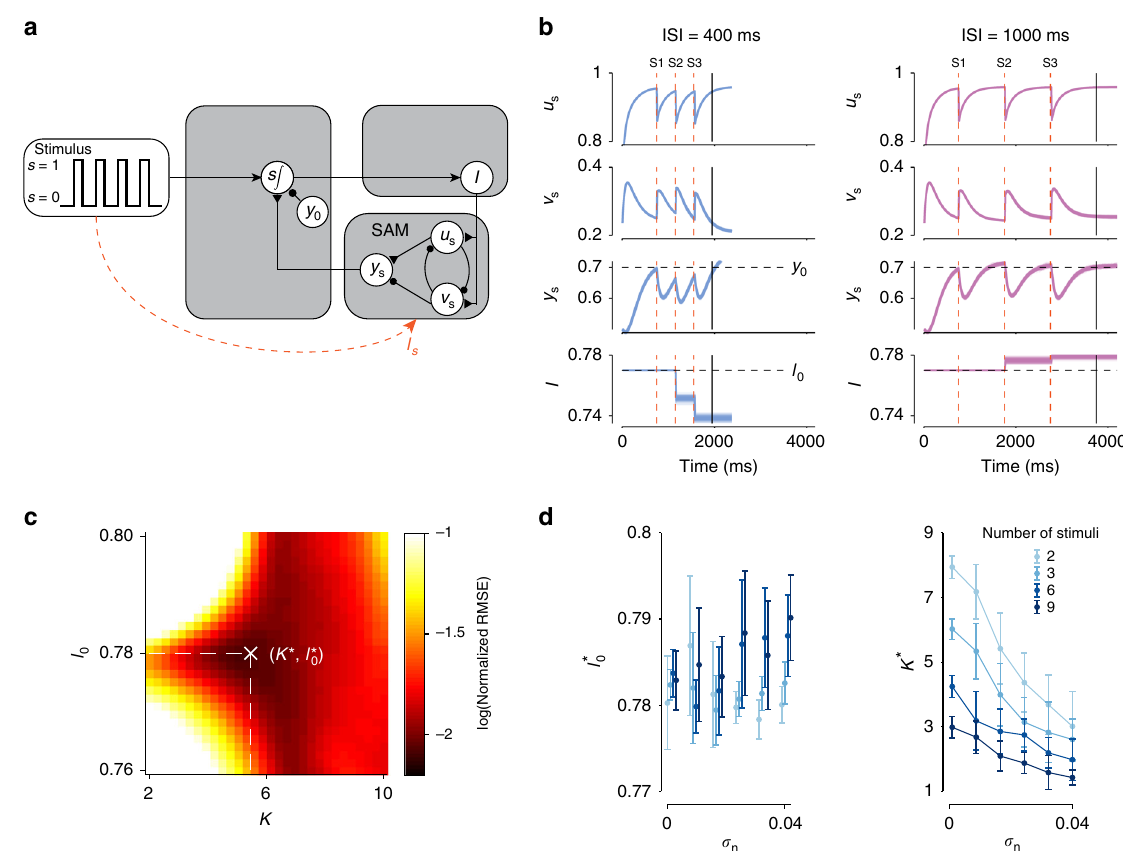
Fig. 3 Dynamic adjustment of input with the sensory anticipation module (SAM). a Architecture of the updating mechanism and SAM. The updating mechanism, represented by s ∫ , relies on the difference between the output of the SAM, y s , and the desired level of activity at the time of each stimulus. This is implemented by integrating the summed activity of y s and a tonically fi ring inhibitory unit, y 0 , into the input unit, I , when the stimulus is on ( s = 1). When the stimulus is off ( s = 0), integration is prevented and I remains constant. Dashed line indicates a stimulus input, I s , directly to u s and v s when s = 1, resetting the SAM after each stimulus. Excitatory connections are indicated by triangles, inhibitory connections are indicated by circles, and non-speci fi c synapses are indicated by arrows. b Response of the SAM units u s , v s , y s , and I to three equidistant stimuli (S1, S2, S3, vertical dashed lines) with an ISI of 400 ms (blue) and 1000 ms (pink) with K = 5.0, I 0 = 0.77, σ n = 0.01. The vertical black line indicates the time of the stimulus which is to be predicted. The four panels show how the activity of the four units u s , v s , y s , and I , changes with time in different simulation runs. Each panel contains 100 superimposed lines, each corresponding to the activity of that unit in a different trial. The horizontal dashed lines indicate the threshold y 0 (bottom middle panel) and I 0 (bottom panel). c Example optimization of the value of the weight given to the update, K , and I 0 , at noise level σ n = 0.005 and N = 3 stimuli. Color scale represents the RMSE for each pair of K and I 0 tested, based on 100 simulated trials for each ISI and σ n = 0.005. d The optimized parameter values, K * and I (cid:3) as a function of the level of noise, σ n , and number of input stimuli (colors). Centers and error bars indicate the mean and standard deviation across n =